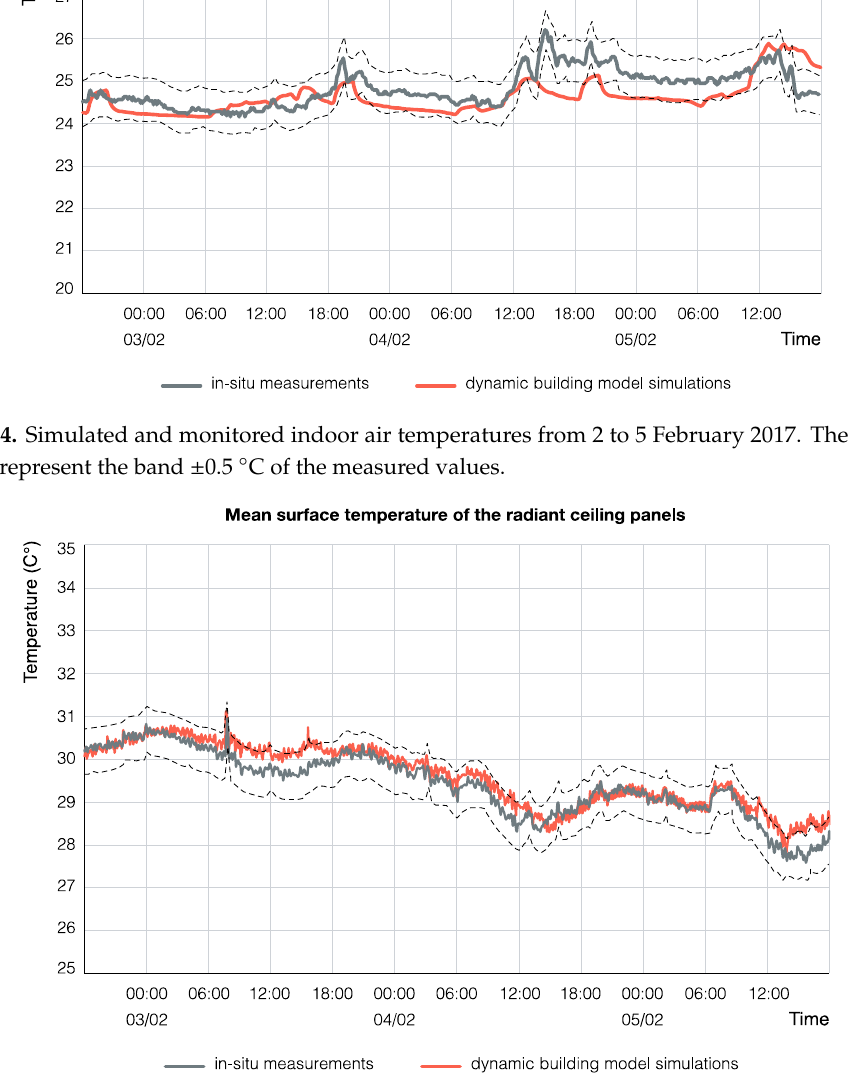
Figure 5. Simulated and monitored mean surface temperatures of the active radiant panels from 2 to 5 February 2017. The dashed curves represent the band ±0.5 °C of the measured values. The grey line reports the values gathered from in situ measurements. Two dashed lines plotted with an offset of ±0.5 °C above and below the grey line represent the sensor accuracy (Table 1) employed for the measurement of indoor air temperature. The temperature distributions obtained from simulations are outlined by the reddish line.